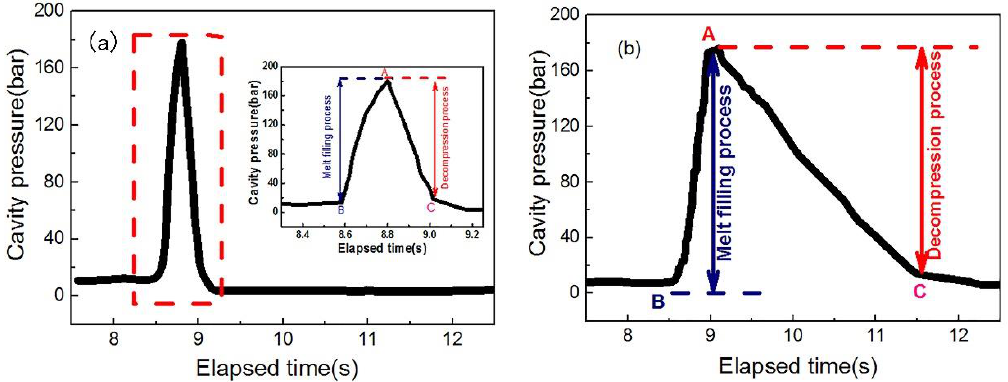
Figure 14. Diagram of the cavity pressure change in ( a ) the core-back injection process and ( b ) the short-shot injection